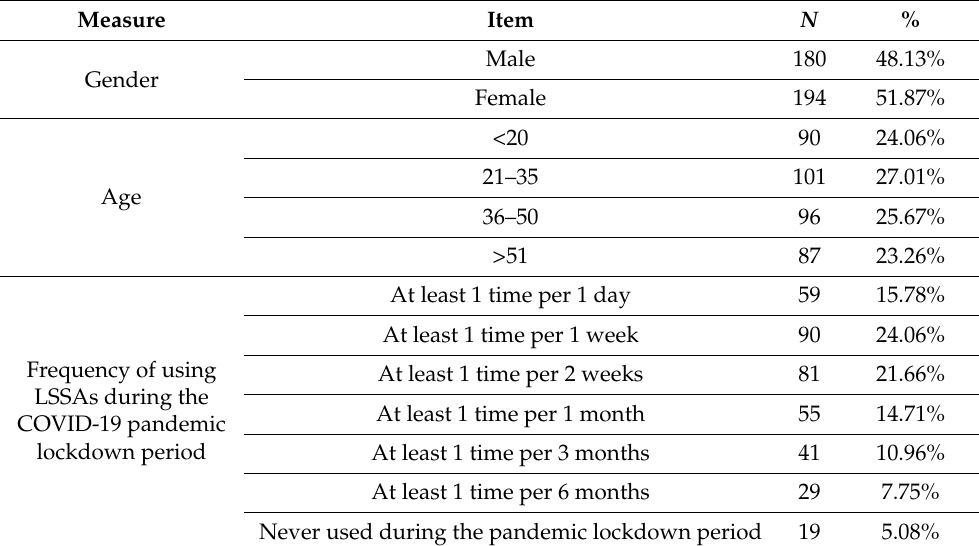
Table 2. Demographic distribution of